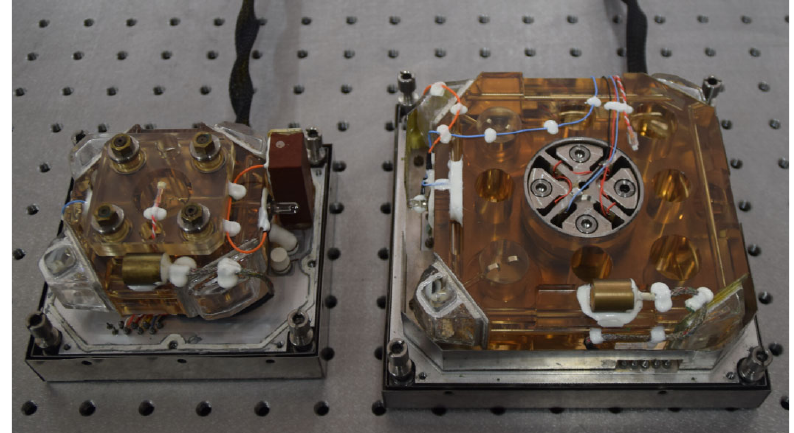
Figure 10. The frequency ‐ stabilized prism ring laser.